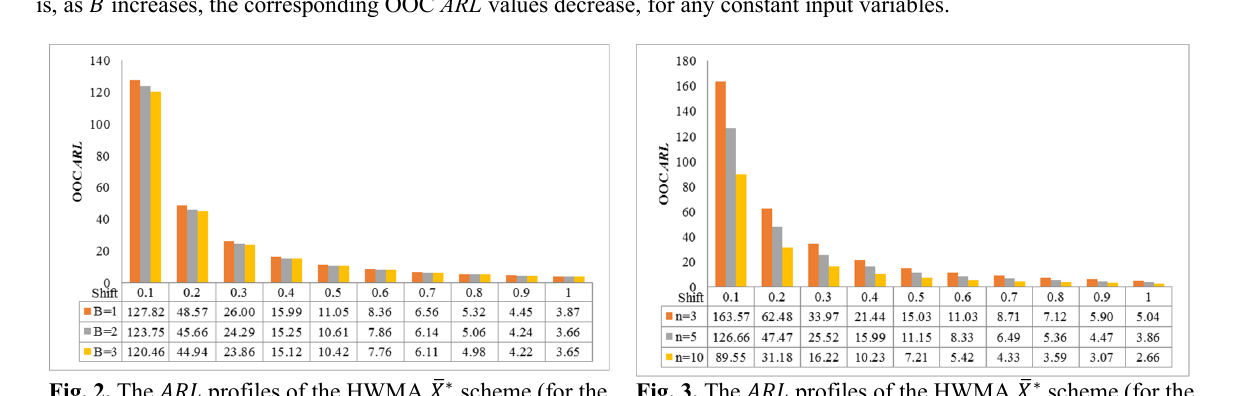
=500 for (cid:2868)